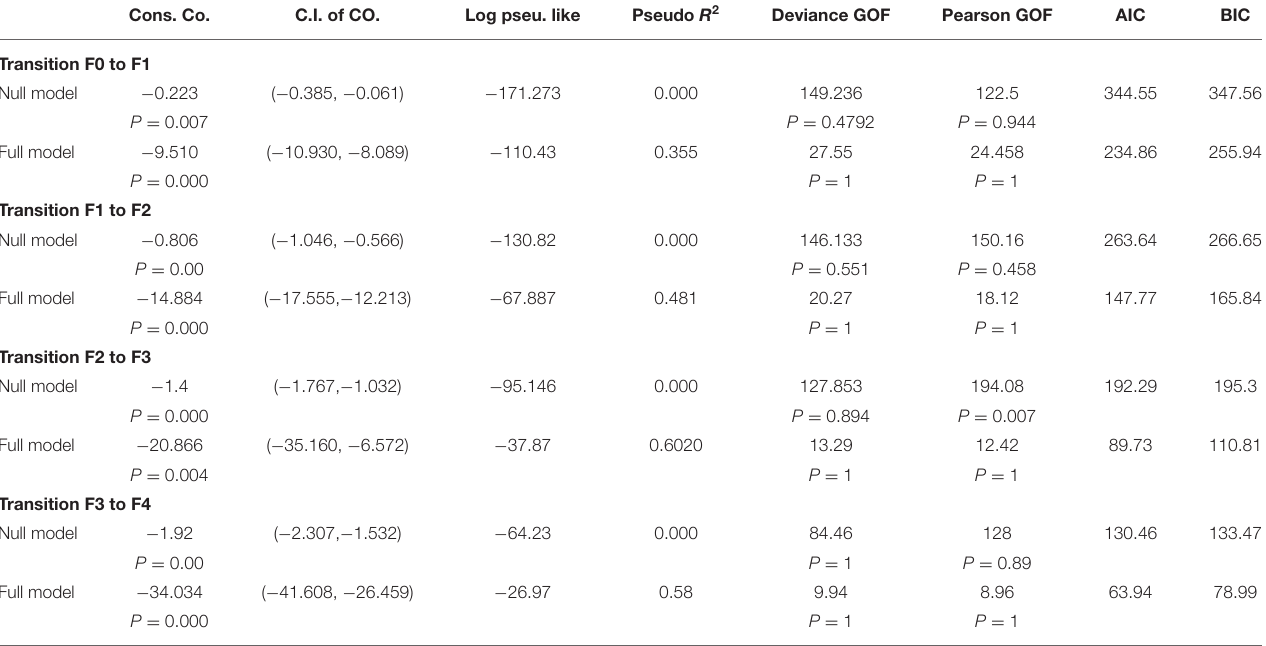
TABLE 6 | Comparison between null and full model as regards the progressive transitions. Cons. Co.